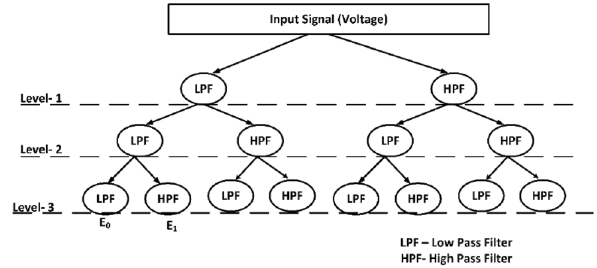
Fig. 9 Output voltage waveform for an open circuit fault condition in a No Fault b Switch P S